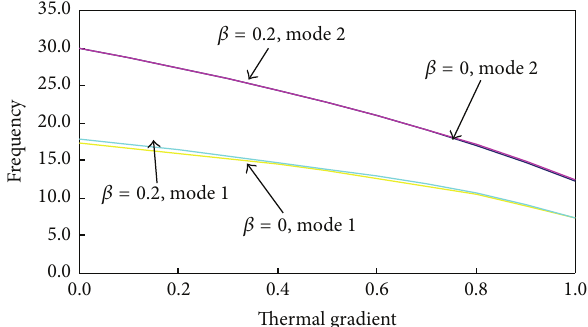
Figure 4: Value of frequency parameter for orthotropic trapezoidal plates for different values of taper constant and fixed values for 𝑎/𝑏 = 0.75 , 𝑐/𝑏 = 0.5 .